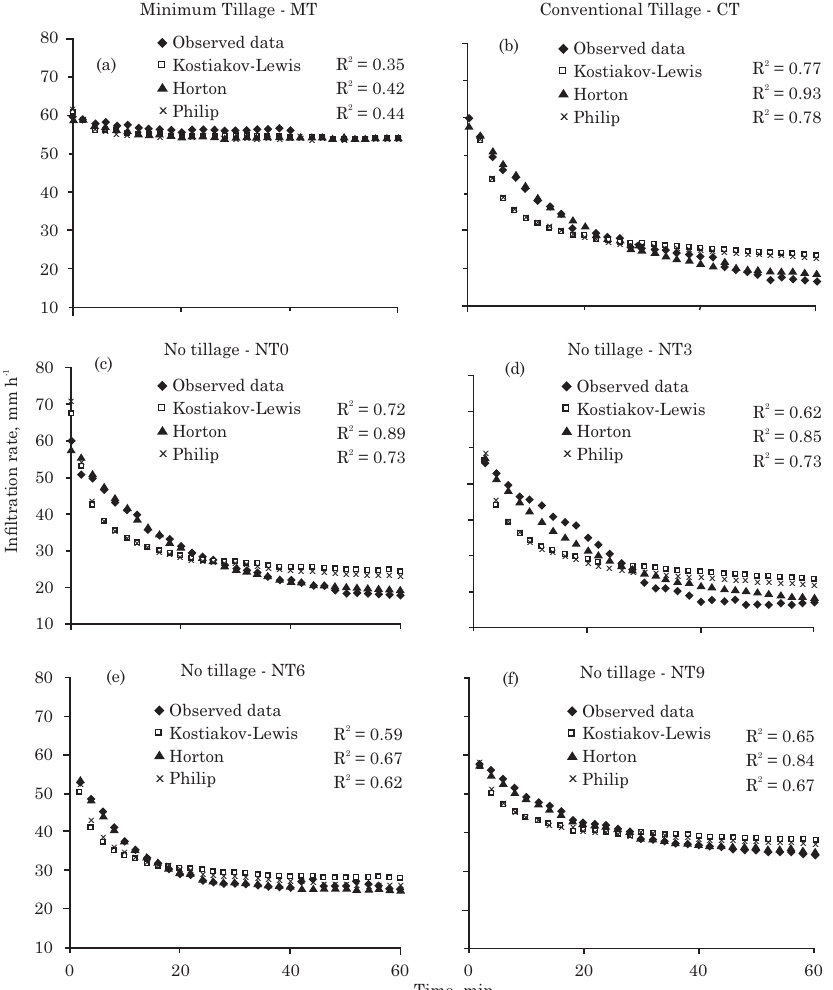
Figure 1. Infiltration rate observed and estimated based on the Kostiakov-Lewis, Horton, and Philip models for the treatments: (a) minimum tillage (MT); (b) conventional tillage (CT); (c) no tillage without plant residue (NT0); (d) no tillage with 3 Mg ha -1 of plant residue (NT3); (e) no tillage with 6 Mg ha -1 of plant residue (NT6); and (f) no tillage with 9 Mg ha -1 of plant residue